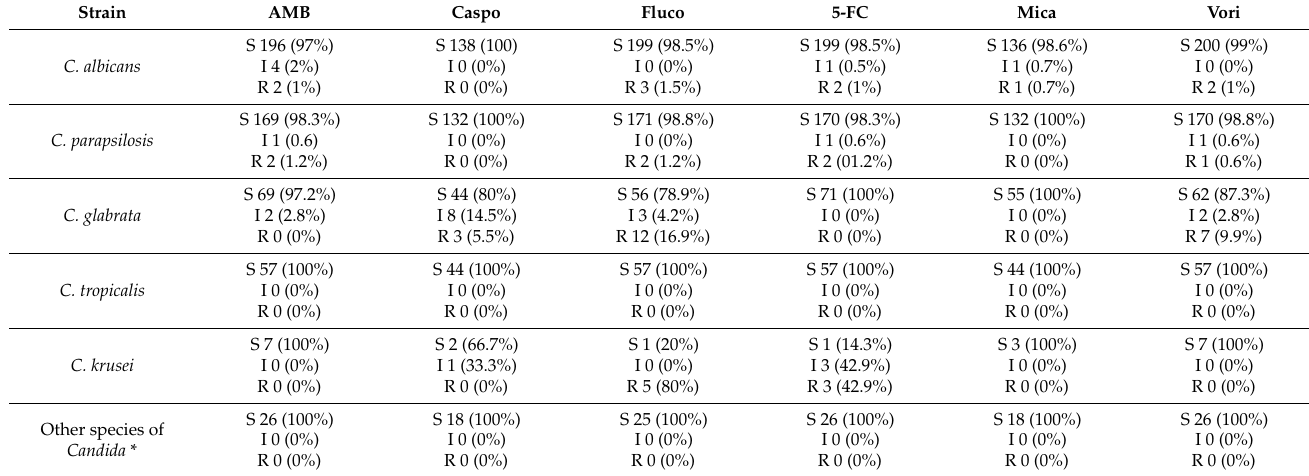
Table 2. Resistance of Candida strains to